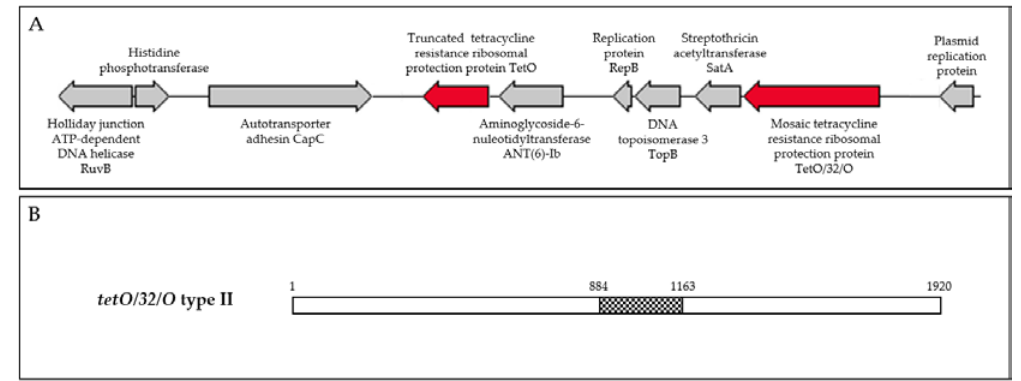
Figure 1. ( A ) Schematic of Campylobacter jejuni isolate CITCj625-18 multidrug resistance genomic island. ( B ) Schematic of the mosaic tetO / 32 / O type II gene detected in CITCj625-18 and CITCj727-18. Figure adapted from Warburton et al. (2016). White bars are tetO and central, checked bar is tet32 (297